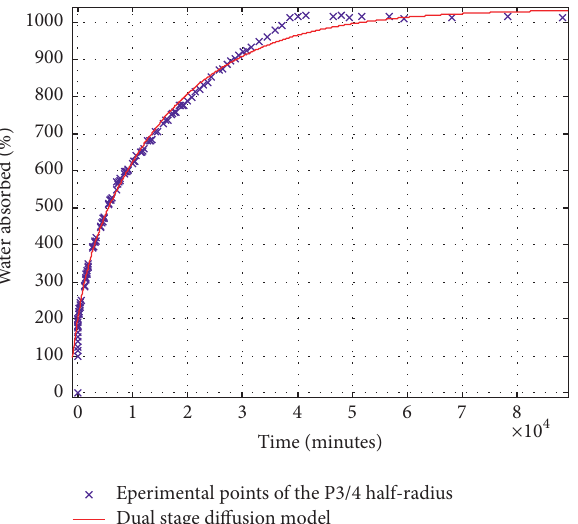
Figure 7: Curves of the water absorption rate and the two-phase diffusion model in part 3/4 in the half-radius zone.